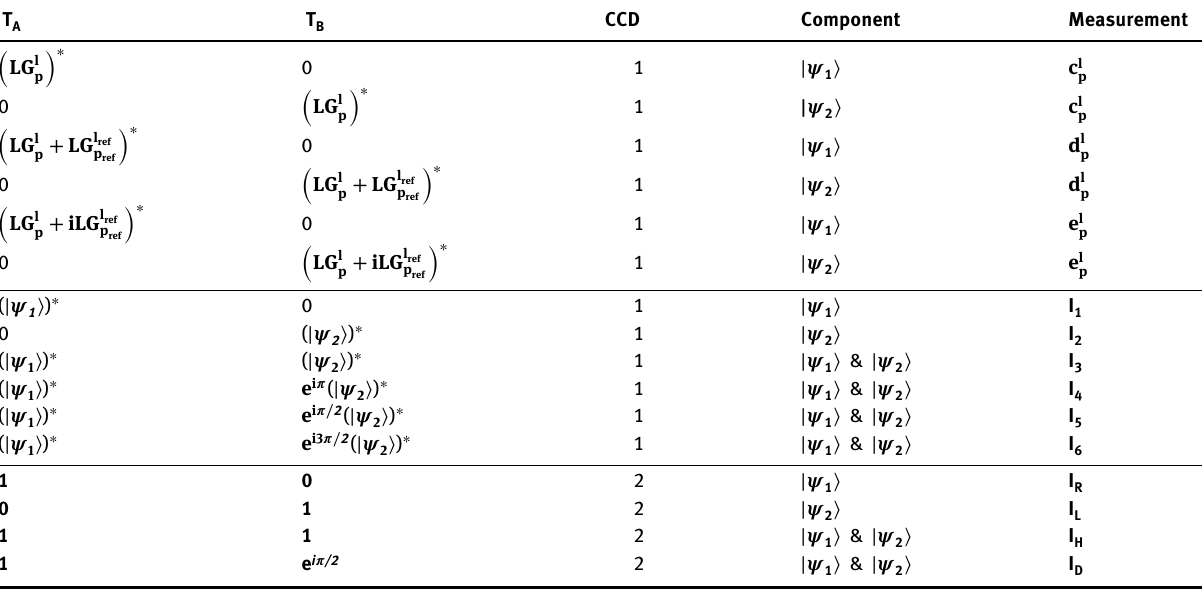
Table 1: Table showing the transmission functions T A ( B ) used to acquire measurements to specify: orthogonal circularly polarized components of a vector field (top), the relative amplitudes and phases of the orthogonal components (middle) and the Stokes intensity measurements